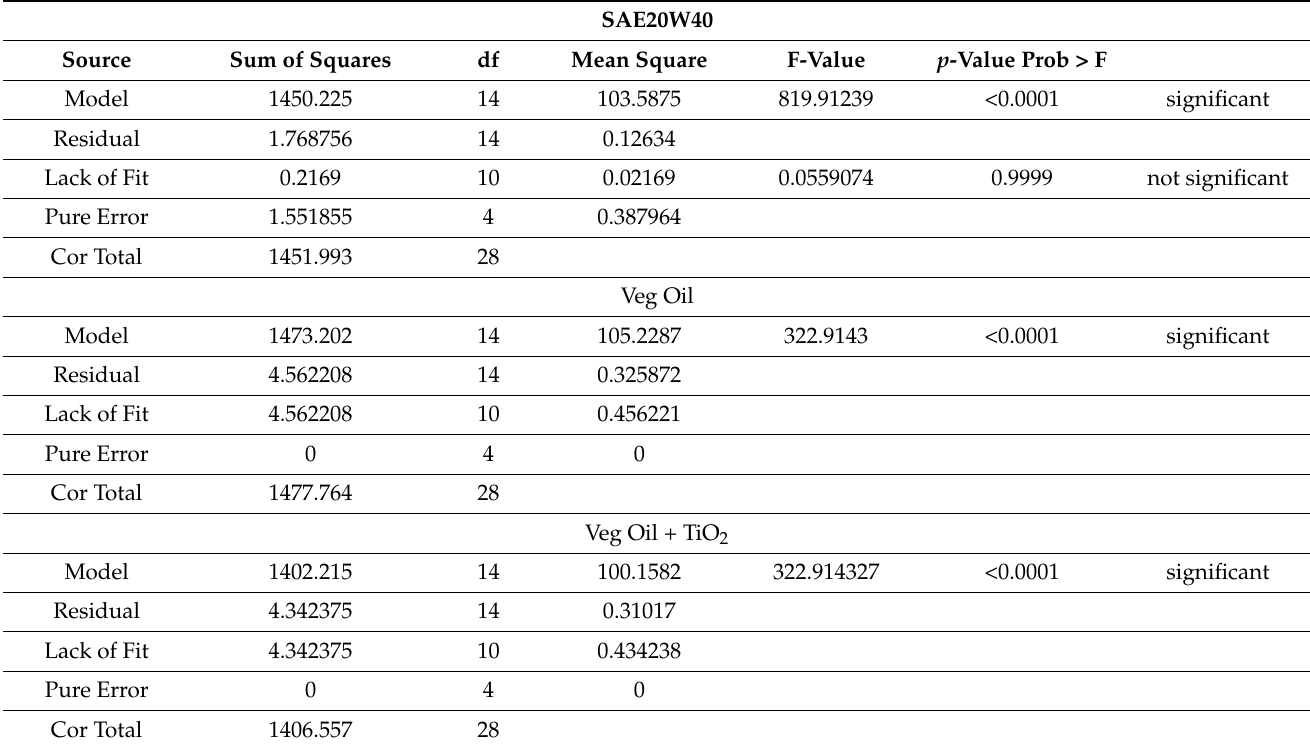
Table 9. ANOVA for cutting